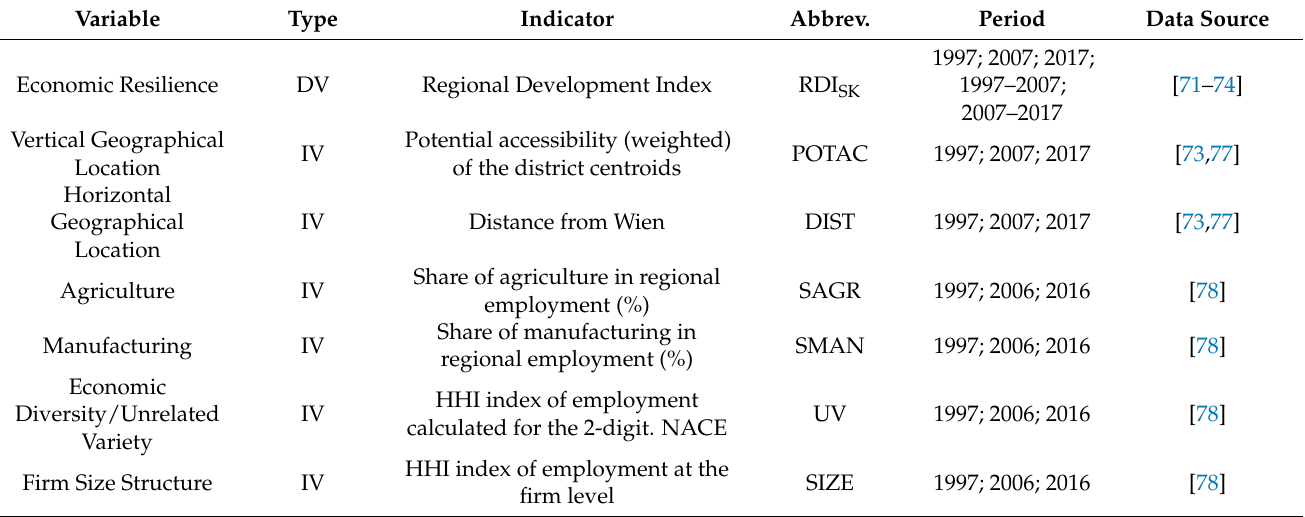
Table 2. Variables employed in regression